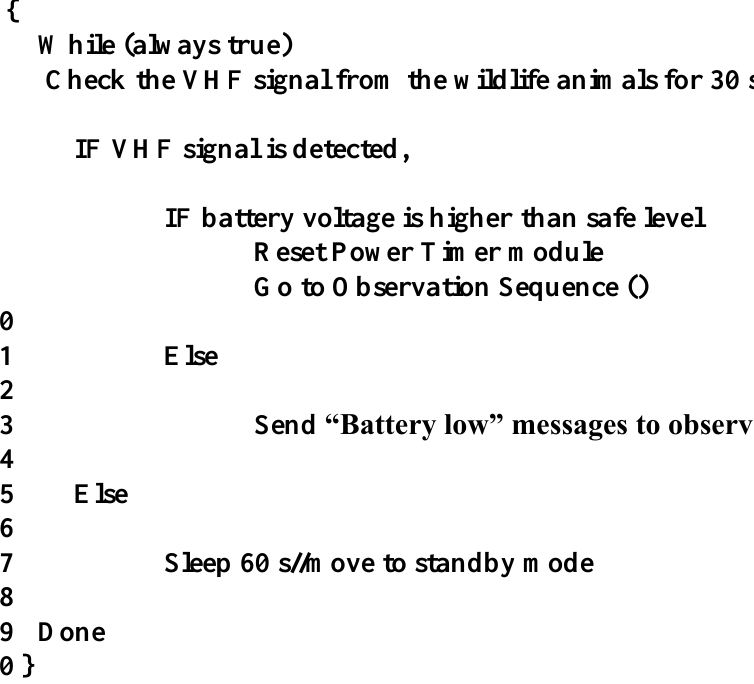
Figure 15. Pseudocode for the observation sequence